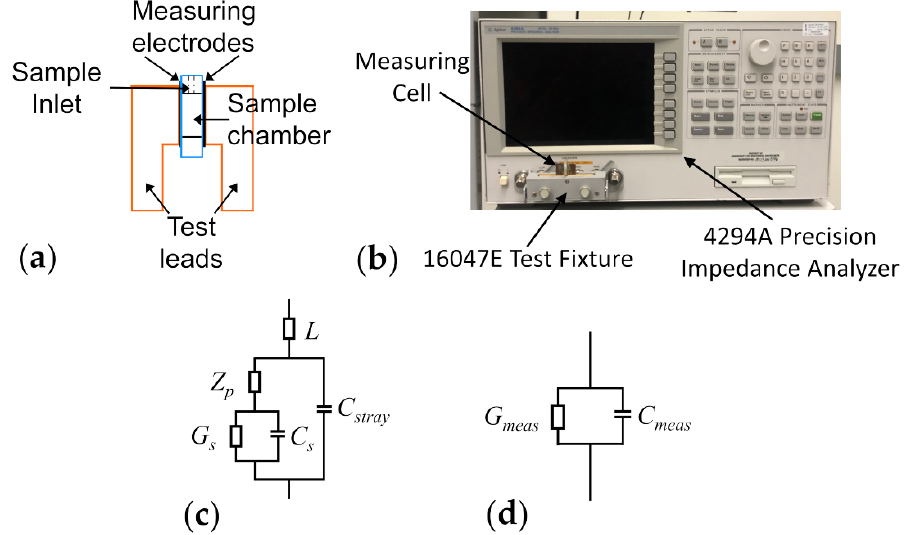
Figure 1. Depiction of the measuring cell and its equivalent circuit. ( a ) Schematic of the parallel- plate capacitor measuring cell. ( b ) Photo of the dielectric spectroscopy measurement setup. ( c ) Electrical circuit describing the measuring cell together with the sample. The sample conductance and capacitance, G s and C s , respectively, appear in series with the impedance characterizing the electrode polarization ( Z p ). This combination is in parallel with the stray capacitance ( C stray ) of the measuring electrodes and in series with the inductance ( L ) of the copper leads. ( d ) Equivalent electrical circuit, consisting of a parallel combination of the measured conductance and capacitance ( G meas and C meas ). These are the values obtained from the measurement apparatus and modelled using Equation (8).